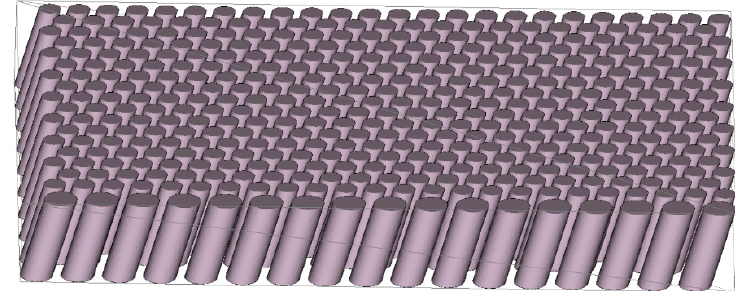
Figure 17. Arrangement of the CGx on BP_1_2-2 and 1_3-2.